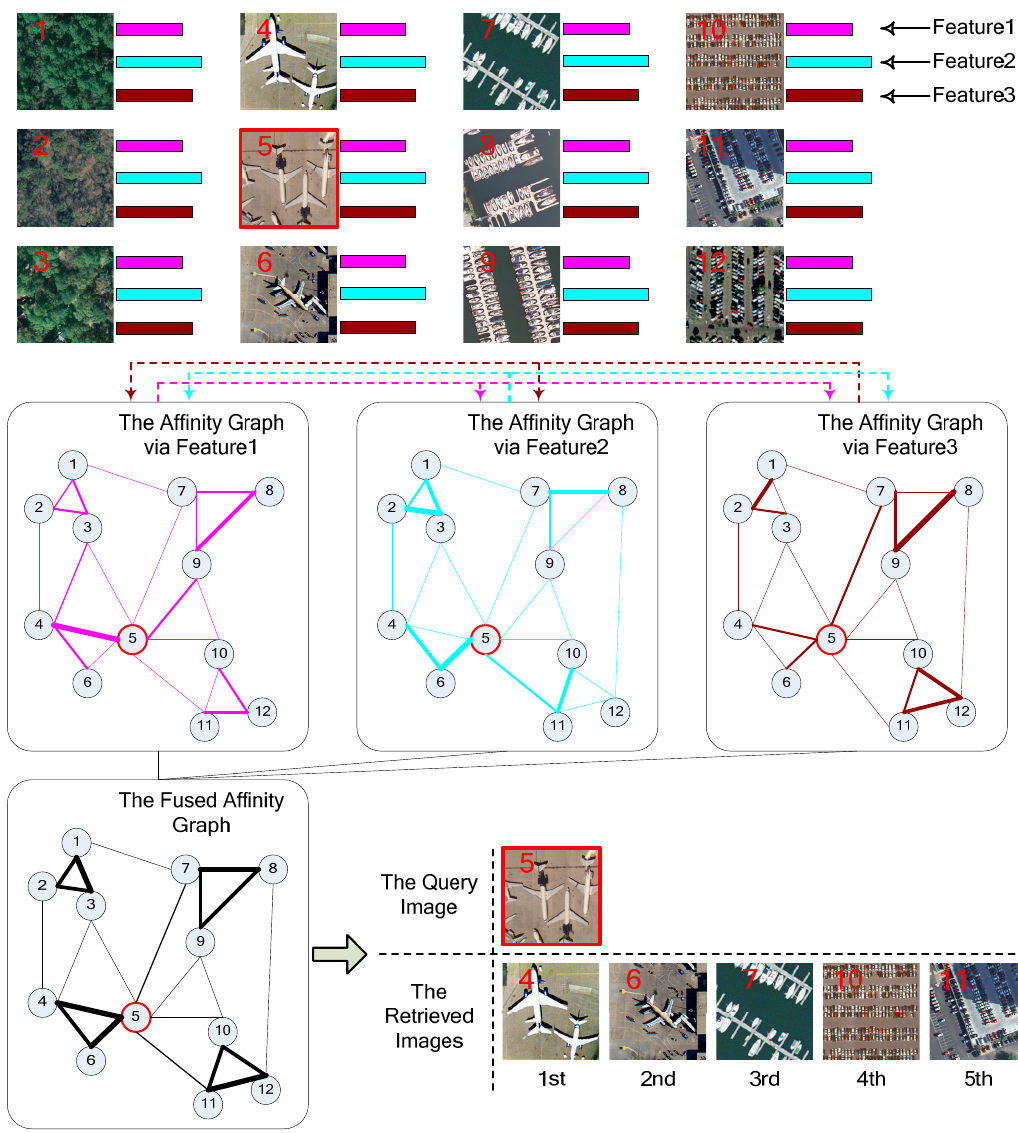
Figure 3. A simplified exhibition of the proposed content-based high-resolution remote sensing image retrieval approach. The link between two nodes of one graph reflects the affinity between them. More specifically, if the link is thicker, the affinity value between the two connected nodes is larger. It is noted that one link should exist between any pair of nodes in the graph, and this illustration only shows parts of critical links. In the toy example, the number of the feature type M is set to 3, and the volume of the image dataset N is 12. Given one query image, the top five retrieved images are shown.